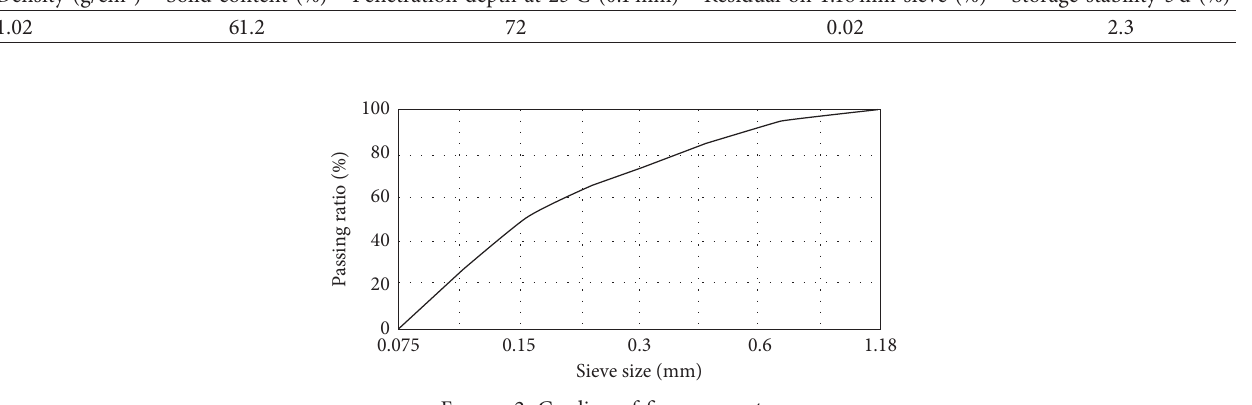
Figure 2: Grading of fine aggregates. Table 3: Mix design of CAM with and without nanoparticles (kg/m 3 ).